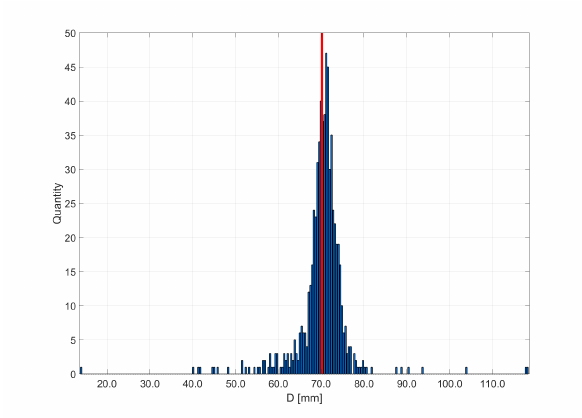
Figure 7. Histogram of the length of the motion vectors D in millimeters. The red line shows the mean length.